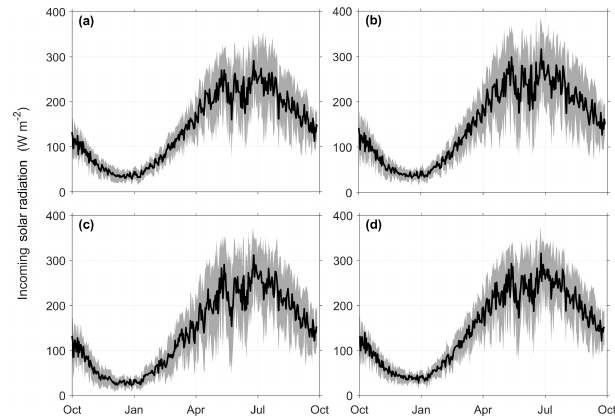
Figure 7. Annual mean daily incoming solar radiation for 11 water years from 1 October 2005 to 30 September 2016 at MCRB stations: (a) Centennial Ridge, (b) Fisera Ridge, (c) Upper Clearing Tower, and (d) Hay Meadow. The line represents the annual mean and the shaded area represents the standard deviation of the 11-year daily incoming solar radiation.